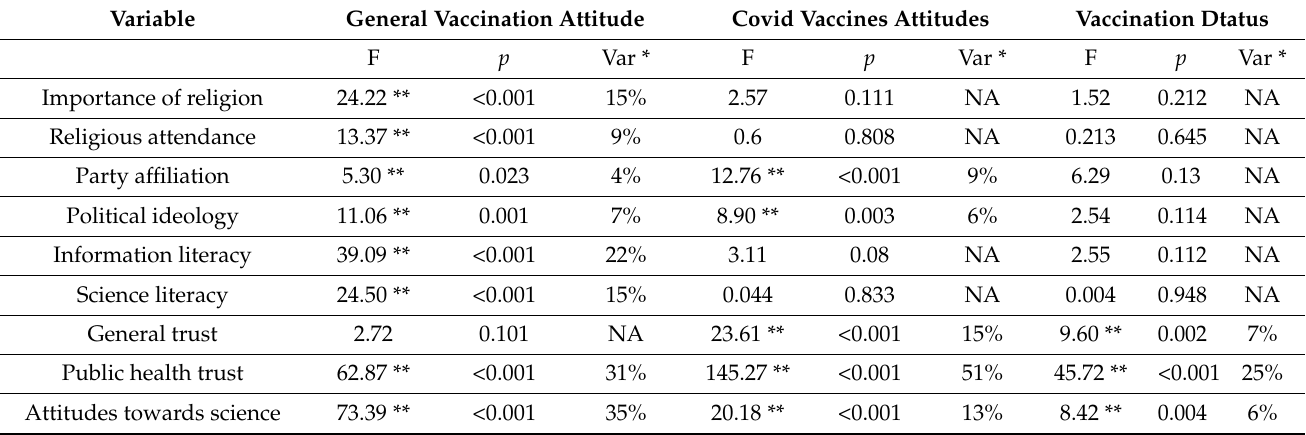
Table 5. Single predictor models analyses.